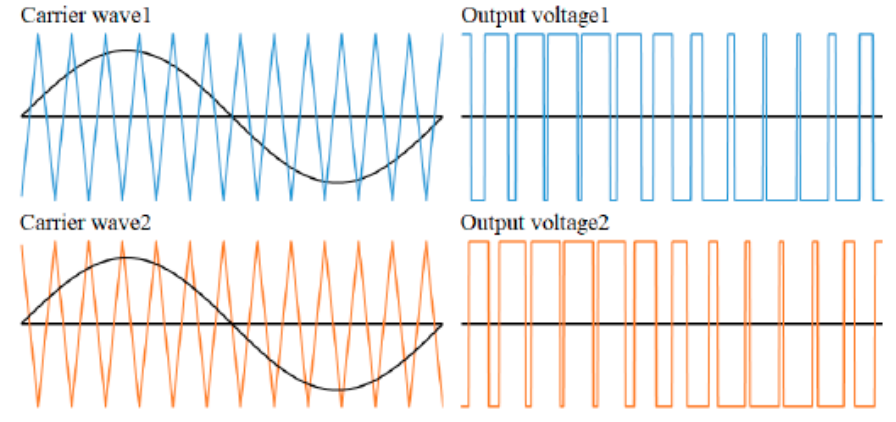
Figure 14. Carrier phase shift control.